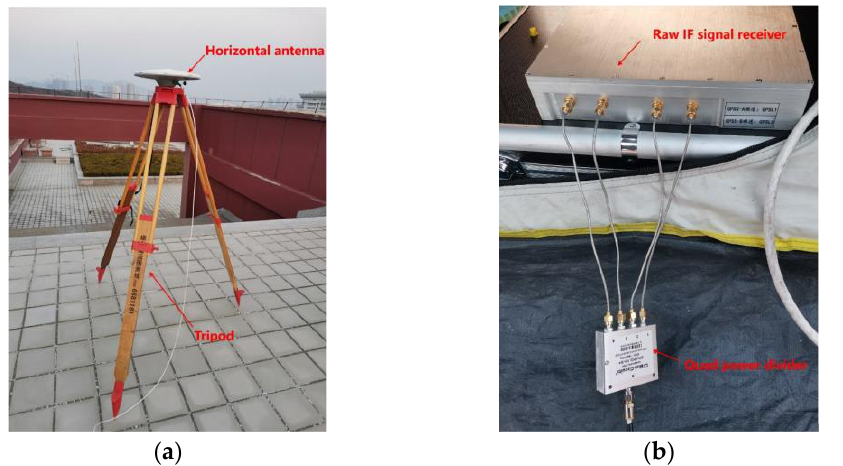
Figure 5. The field of the zero-baseline experiment: ( a ) Horizontally placed geodetic GNSS antenna and its tripod; ( b ) Quad-power divider and raw IF signal recorder.